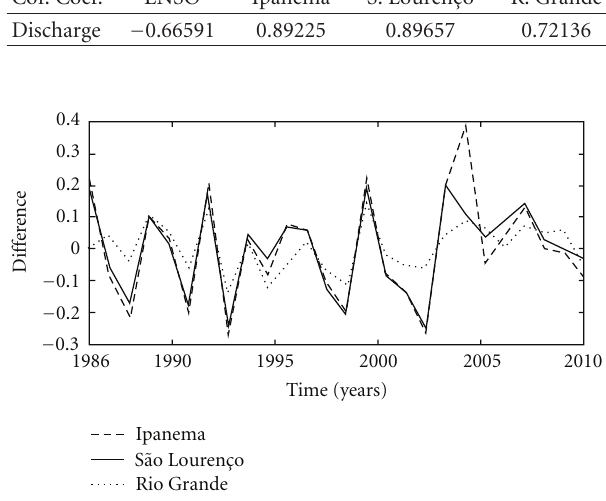
Figure 5: Di ff erence between the observed and calculated water levels between 1986 and 2010 for the stations Ipanema, S˜ao Lourenc¸o, and Rio